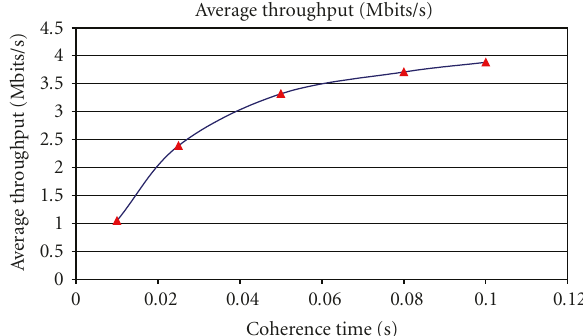
Figure 5: Performances of BMAC when using di ff erent acquisition periods.